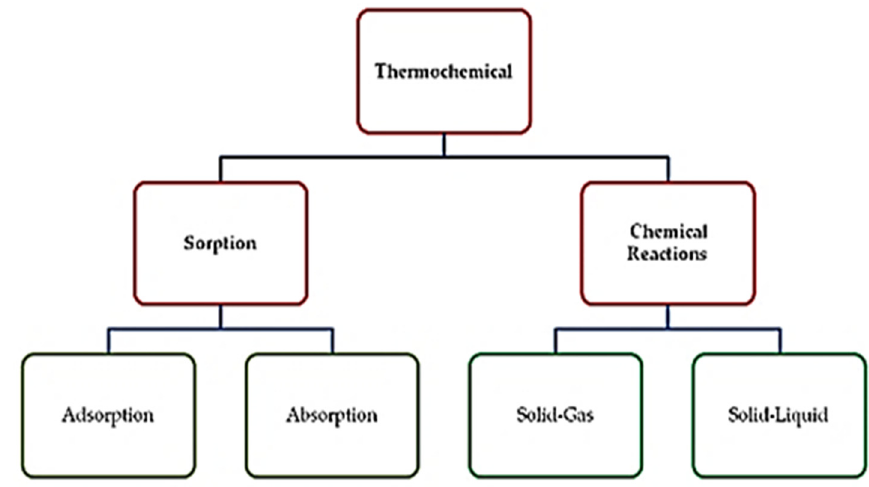
Figure 1. Classification of thermochemical energy storage systems [13].